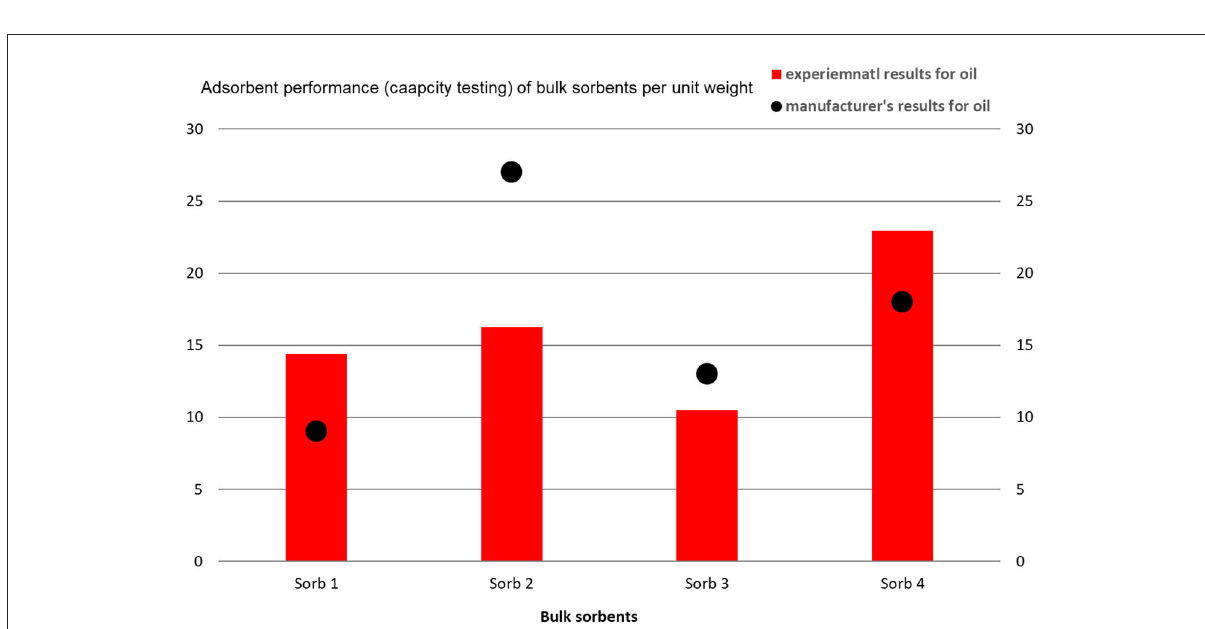
forces after being released into the environment (article 12.4 in safety data sheet). The given parameter is only occasionally stated in SDS or in technical sheets of dangerous